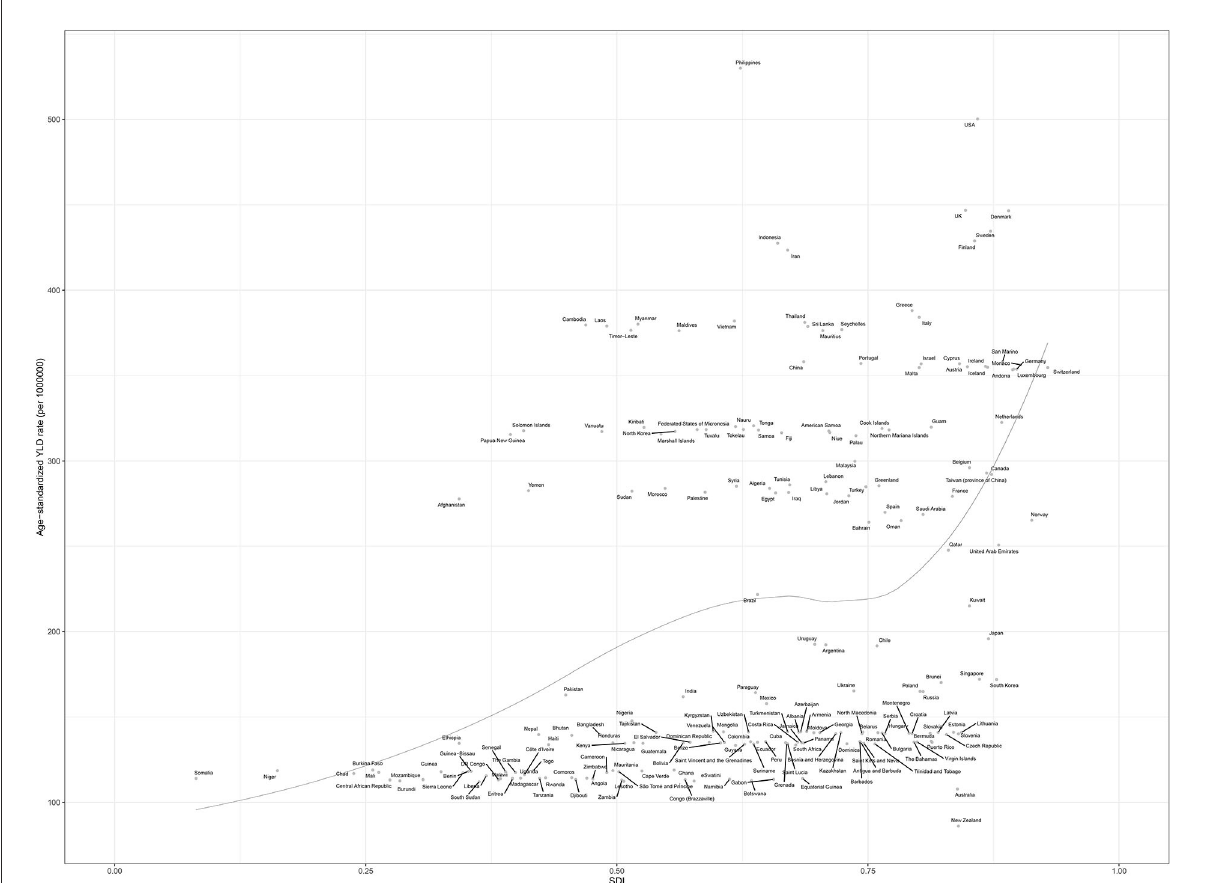
FIGURE5 Age-standardized YLD rate of neck pain for 204 countries in 2019 according to SDI. Each point shows the observed age-standardized YLD rate for a specified country or territory in 2019. The black line represents expected values based on the sociodemographic index and disease rates in all locations. Generated from data available at http://ghdx.healthdata.org/gbd-results-tool. YLD, years lived with a disability; SDI, socio-demographic